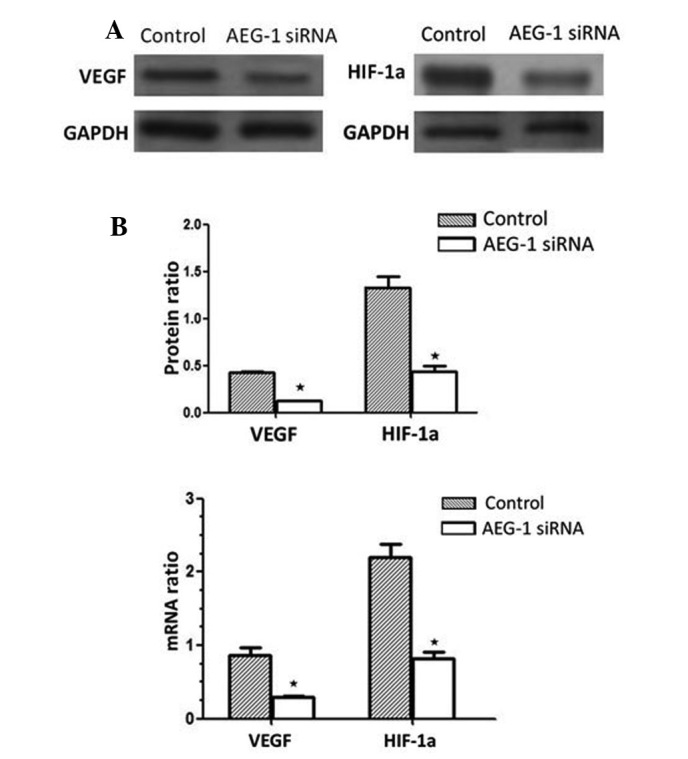
Effects of AEG-1 siRNA on VEGF and HIF-1α expression. MGC-803 cells were transfected with AEG-1 siRNA and Con-siRNA. (A) VEGF and HIF-1α were determined by western blotting. Upper panel shows a representative blot for VEGF and HIF-1α protein, and the lower panel shows the quantification of VEGF and HIF-1α protein levels. (B) VEGF and HIF-1α mRNA were determined by real-time reverse transcription polymerase chain reaction in MGC-803 cells and the levels of VEGF and HIF-1α mRNA are presented as the (VEGF and thrombospondin-1)/GAPDH mRNA ratio. Data are presented as means ± standard deviation of three independent experiments. *P<0.05 vs. Con-siRNA (control). AEG-1, astrocyte elevated gene-1; VEGF, vascular endothelial growth factor; HIF-1α, hypoxia-inducible factor-1α; Con-siRNA, scramble siRNA; GAPDH, glyceraldehyde-3-phosphate dehydrogenase.